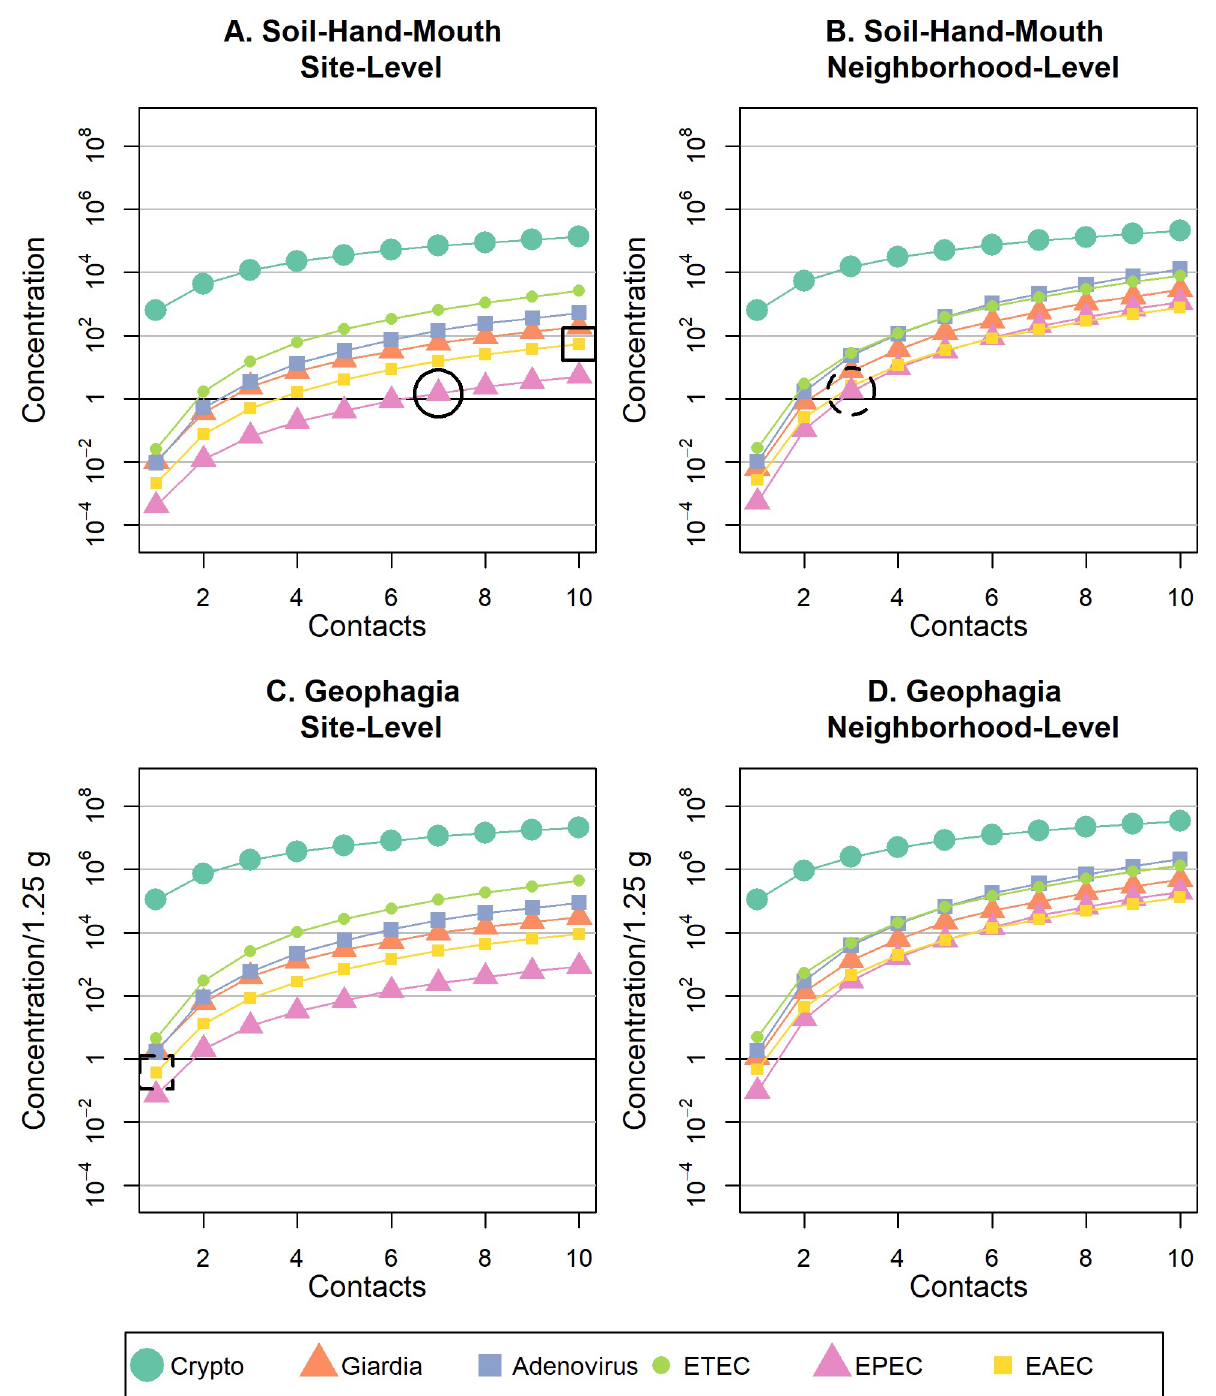
Fig 2. Mean dose of six enteric pathogens ingested with increased frequency of soil-hand-mouth or geophagy behaviors at site-restricted versus neighborhood levels of spatial scale. Mean pathogen doses are shown for (A) soil-hand-mouth exposure behaviors at a single residential public site; (B) soil-hand-mouth exposure behaviors at two or more residential public sites within a neighborhood; (C) geophagy behaviors at a single residential public site; and (D) geophagy behaviors at two or more residential public sites within a neighborhood.